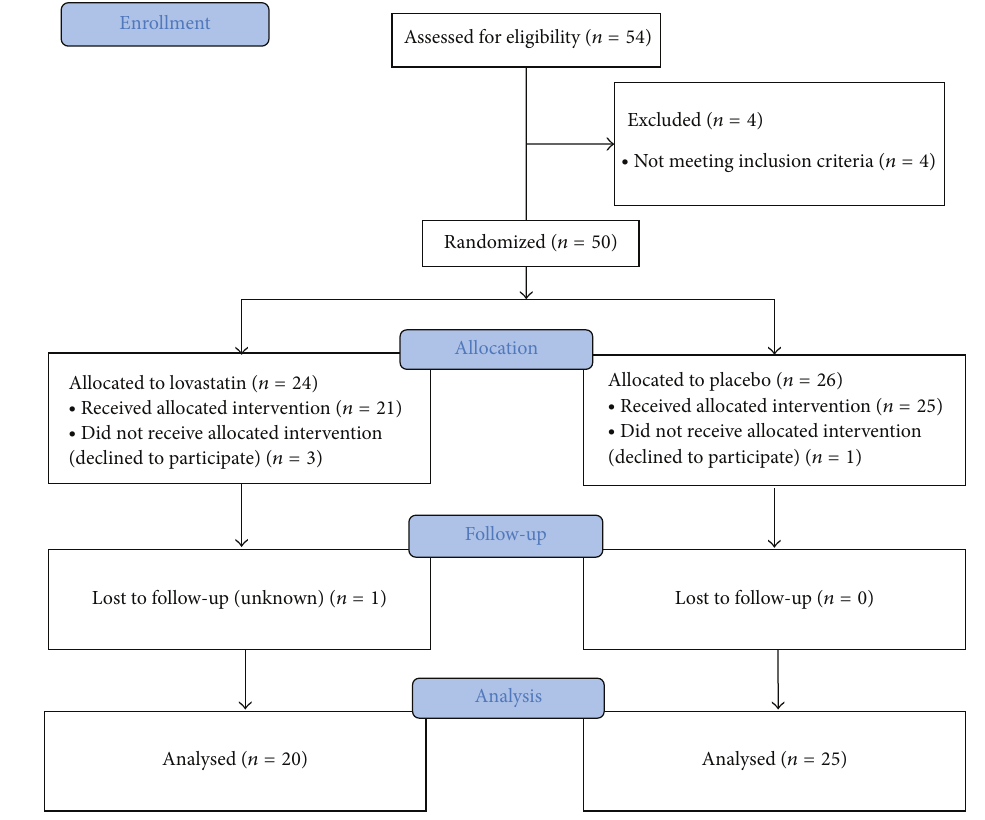
Figure 1: The flow chart of the patients. Table 1: Basic characteristics of the patients in the two groups. Lovastatin group Placebo